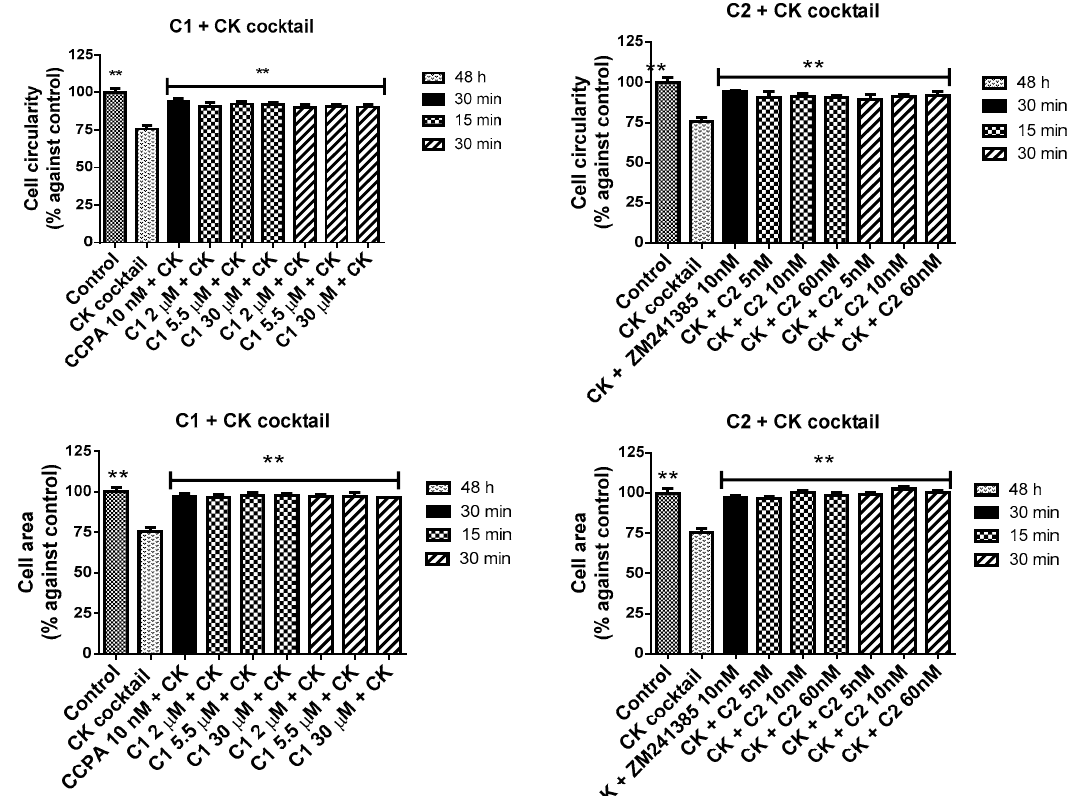
Figure 12. Cell area and circularity after the pre and post treatment with CCPA or C 1 and ZM241385 or C 2 respectively in presence of the CK cocktail in mixed glial cell cultures. The results represent the average of 3–5 independent experiments. ** p < 0.01 of treated cells against